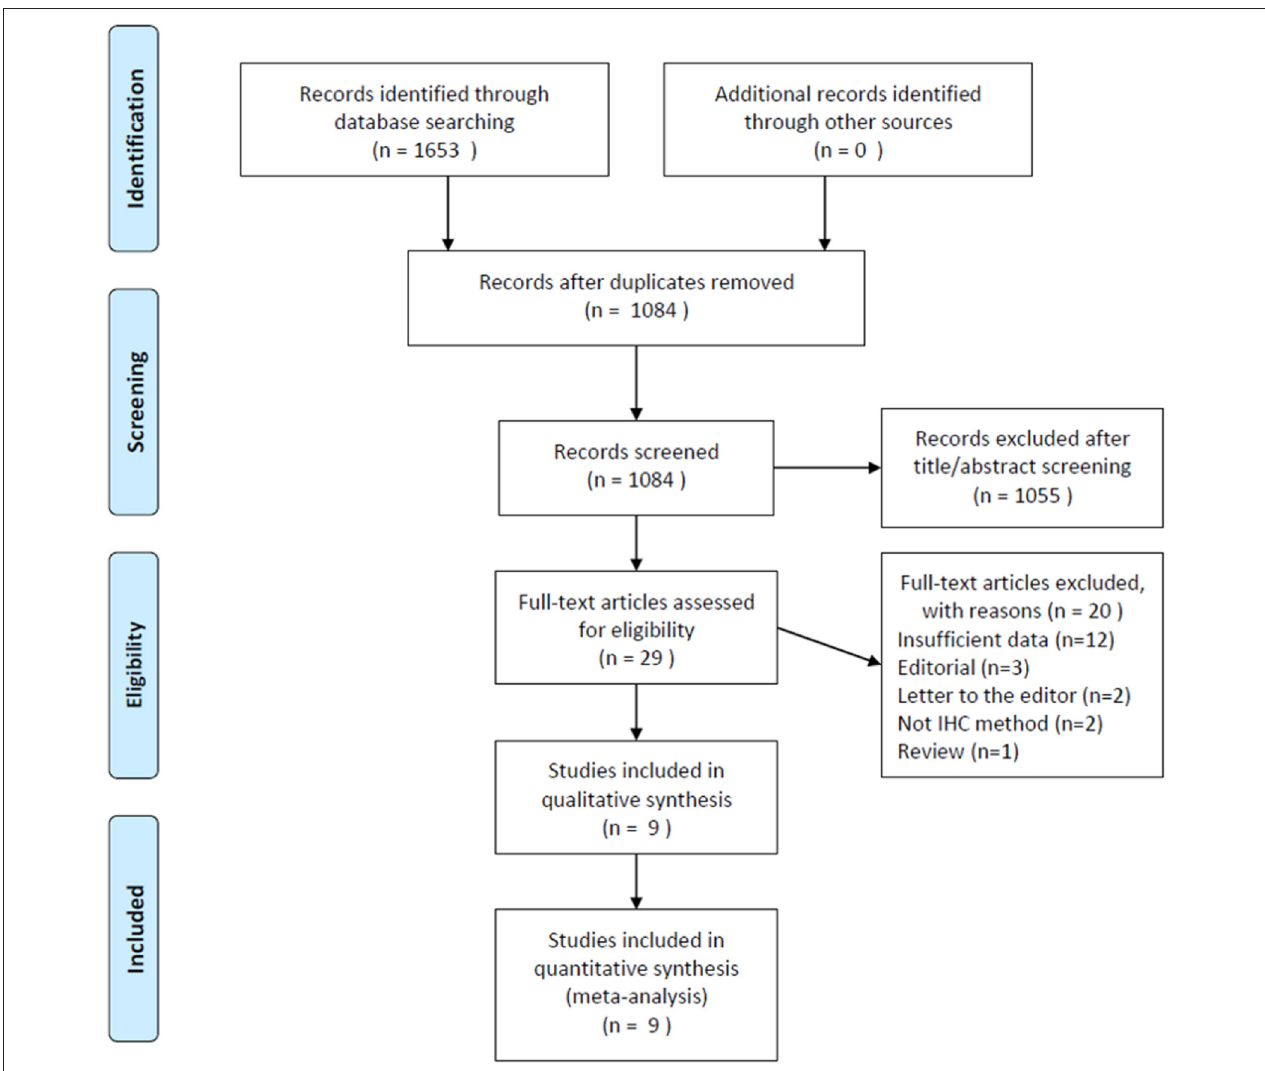
FIGURE 1 | The literature search